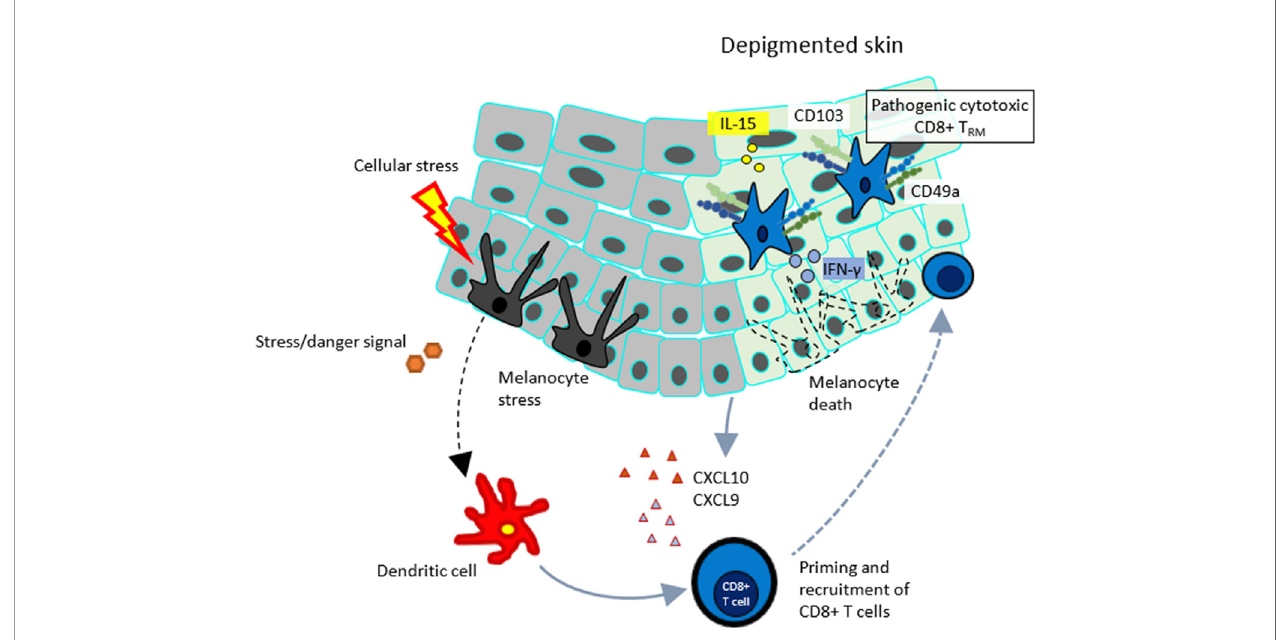
FIGURE 7 | Mechanism of